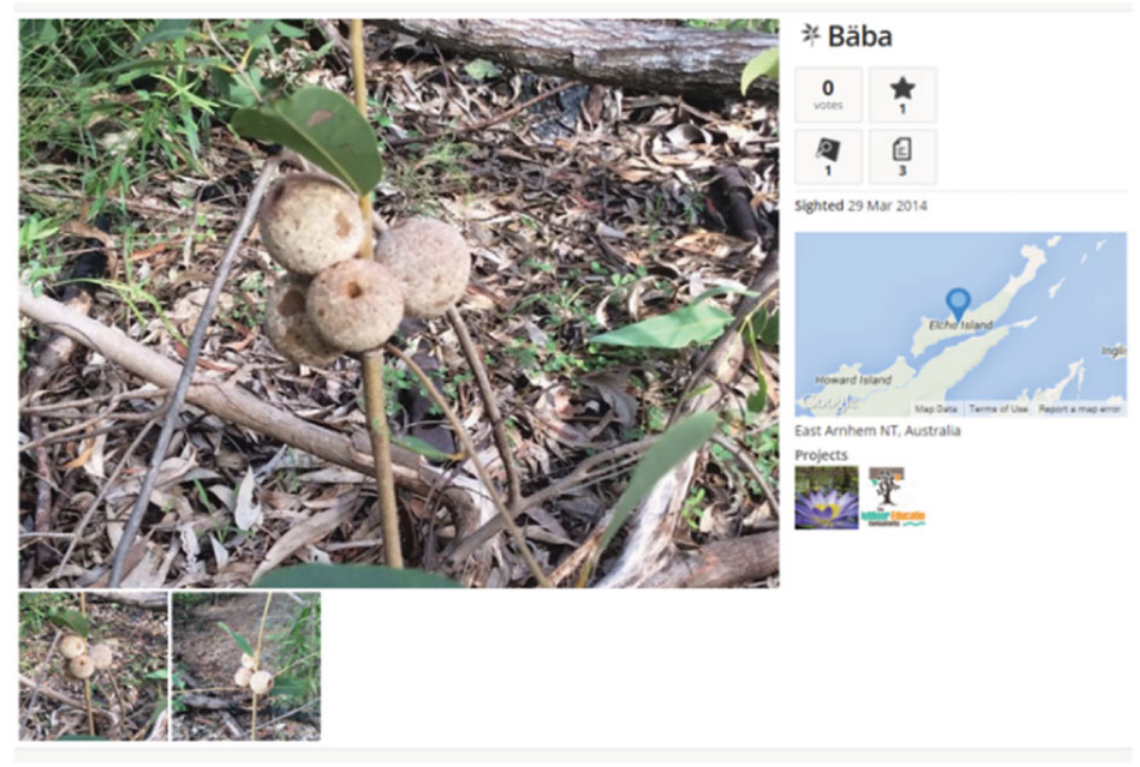
FIGURE 3 (Colour online) The B¨aba